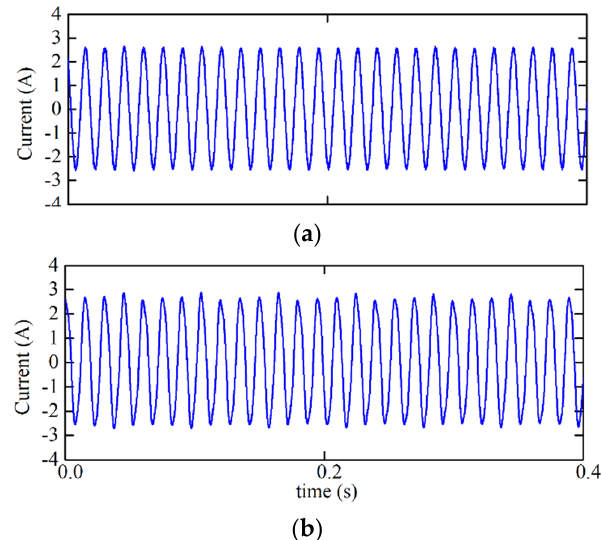
Figure 6. Experimental waveform of current i a under stationary conditions (1000 rpm, peak current: 2.6A). ( a ) Current waveform for healthy PMSM; ( b ) current waveform for partially − demagnetized PMSM.